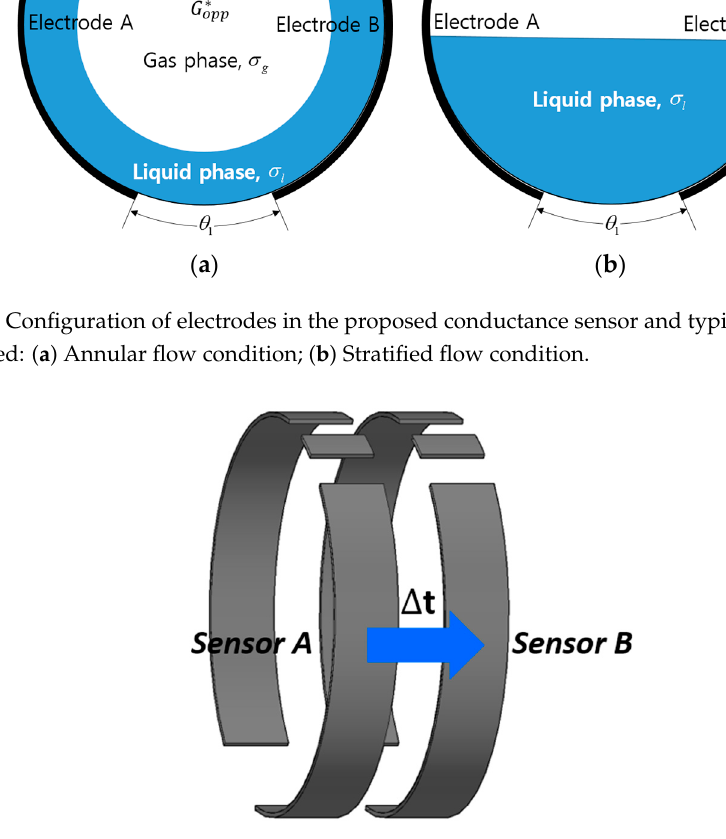
Figure 2. An improved dual conductance sensor system for measurement of the structure velocity.